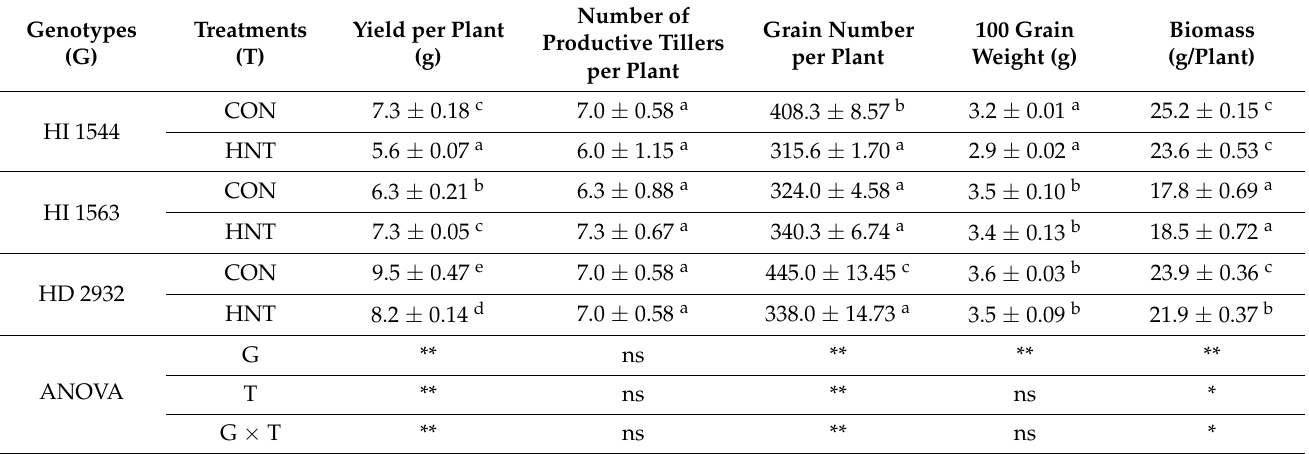
Table 2. Yield components and biomass of wheat genotypes grown under CON and HNT conditions. Values show mean ± SE. Data were obtained from three replications for each genotype. The separation of means was carried out using Duncan’s post hoc test ( p < 0.05). Means with different letters are